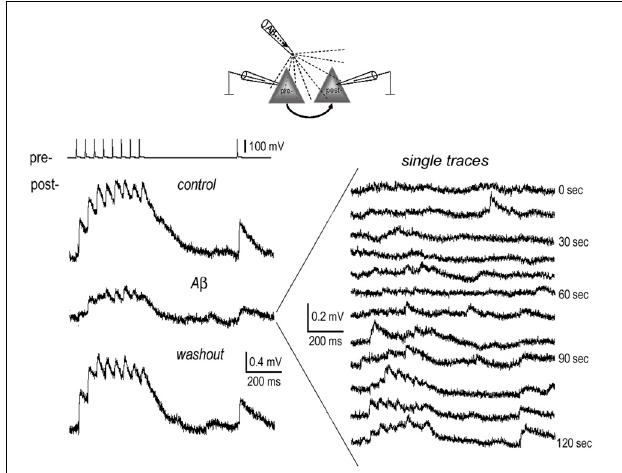
FIGURE 4 | Full recovery of EPSPs from inhibition by brief local application of A β . 1nM A β 42 was briefly applied near the somata of the connected neurons (diagram) for 2min. Recordings were carried out before (pre-application) and at the end of application of A β , and lastly after washout of A β for 10min. The average EPSP traces display full recovery from the inhibition of A β ( left panel ). In the single traces recorded at the end of A β application ( right panel ), the EPSPs almost completely disappeared. These started to recover at ∼ 1min. after terminating the A β